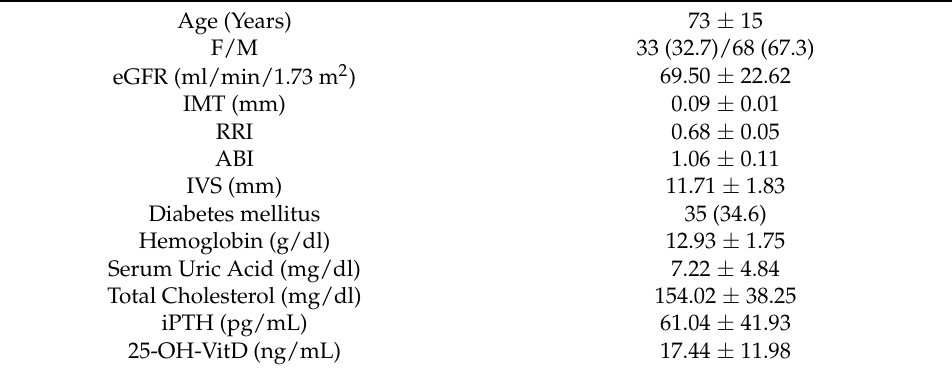
Table 1. Patients’ characteristics. Data are shown as mean ± standard deviation or number (%).